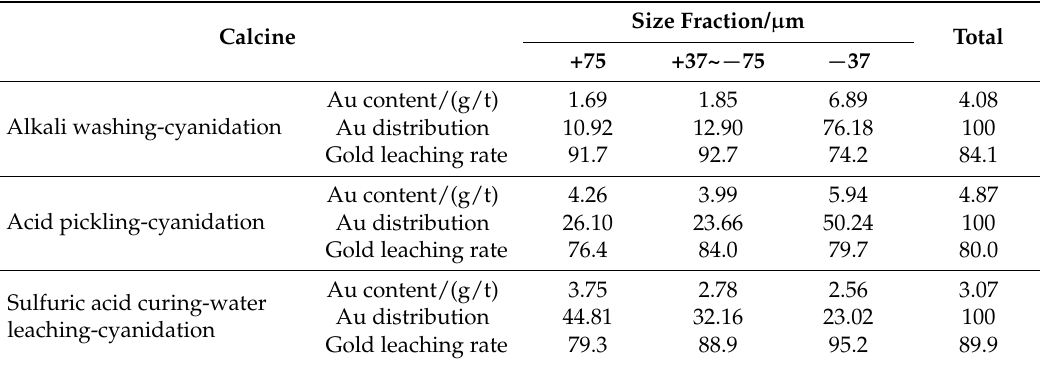
Table 6. Gold extractions from the different size fractions of calcine pretreated by sulfuric acid or sodium hydroxide (mass fraction, %).